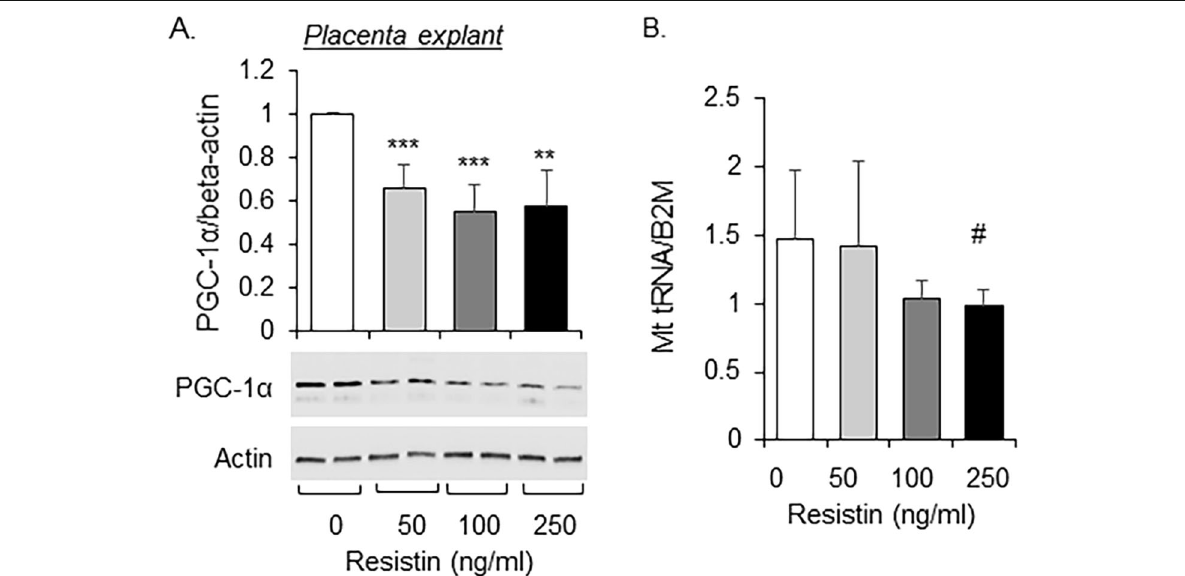
Fig. 4 Effect of resistin on mitochondrial biogenesis in placentae. Human placental explants were treated with indicated doses of human resistin for 24 h. a protein lysates were subjected for Western blot analysis; b total DNA were extracted and mitochondrial DNA copy number was determined by fold change of mitochondrial tRNALeu (UUR) gene DNA copy number normalized to nuclear β 2 microglobin (B2M) with quantitative RT-PCR. Mean ± SD, ** P < 0.01; *** P < 0.001; N = 4. # P < 0.05 with one-tail